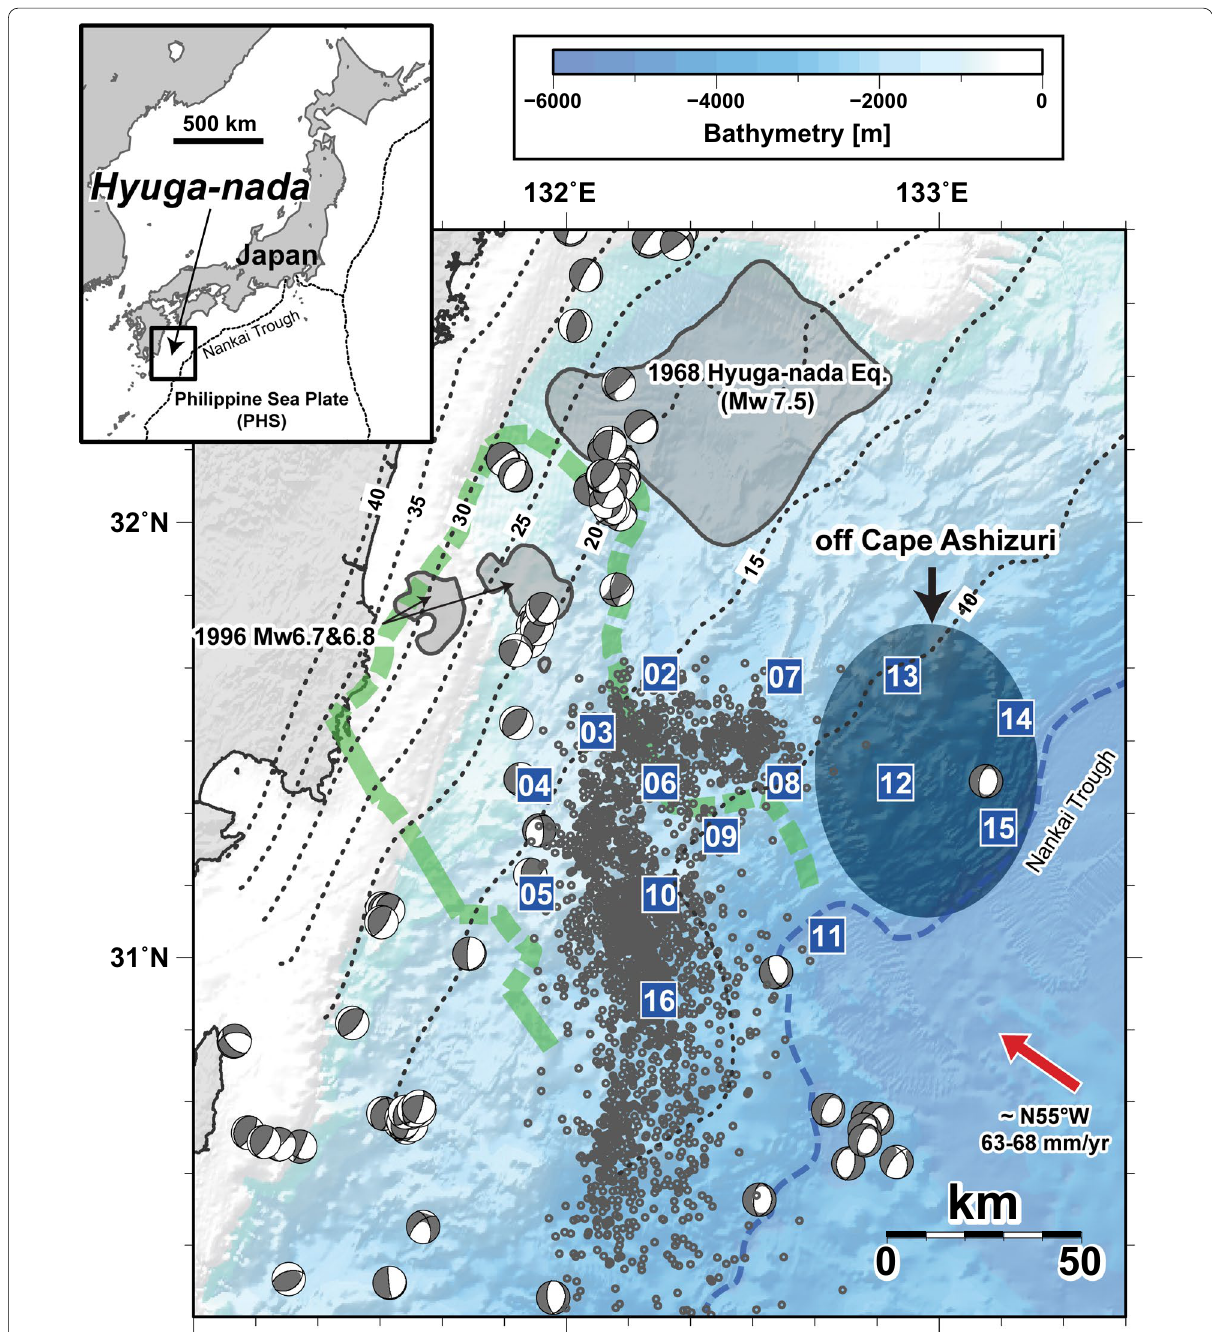
Fig. 1 Locations of all OBS stations used during the observation periods in the Hyuga-nada region and the simplified regional tectonic setting. Blue squares and numbers represent OBS station locations and numbers, respectively. Gray circles indicate shallow tremor activity in 2013 (Yamashita et al. 2015). Black dotted lines are depth contours of the top of the Philippine Sea Plate (Nakanishi et al. 2018). Gray shaded areas represent the coseismic slip area of the 1968 Hyuga-nada and 1996 earthquakes (Yagi et al. 1998, 1999). The light green bold line delineates the outer edge of the subducted Kyushu–Palau Ridge (Yamamoto et al.